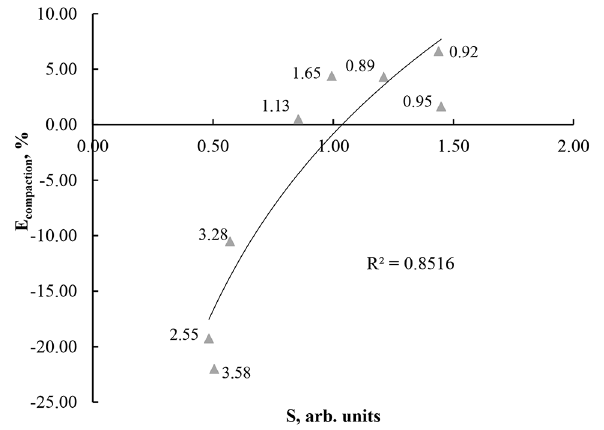
Fig. 11 Correlation of the degree of coal matter compaction during cyclic nanoindentation with amorphous carbon share. Numbers near the dots denote vitrinite reflectance index R o,r of the corresponding coal